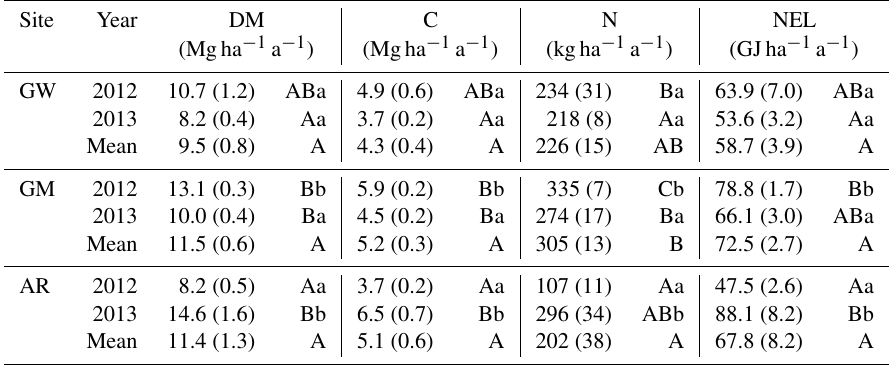
Figure 5. CO 2 exchange at the four study sites during a 2-year study period (April 2012–March 2014). Values are displayed as daily means of the model output ( n = 3). The black continuous line shows the cumulated NEE for 1 year. The black dots represent CO 2 measurement campaigns. Table 3. Annual yields of dry matter (DM), carbon (C), nitrogen (N) and net energy lactation (NEL) for the three agricultural utilized study sites and 2 years. Different capital letters indicate significant differences between the sites for a particular year. Different lowercase letters indicate significant differences between the years for a particular site ( p <0.05). Values in brackets are standard errors ( n = 3). Crops at site AR were summer barley (2012) and summer wheat with undersown grass